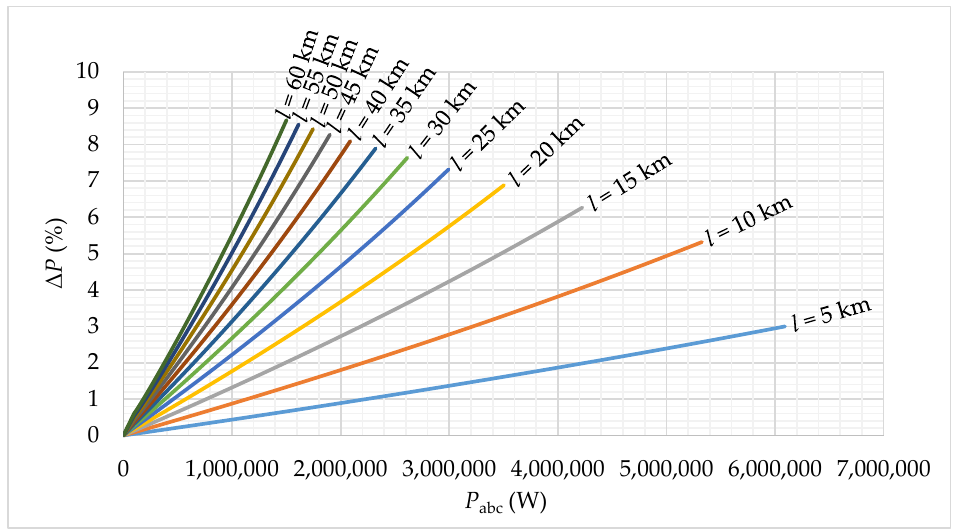
Figure 6. The dependence of increasing APLs from three-phase active power consumption for ACSR 70/11 with consideration of voltage dip.